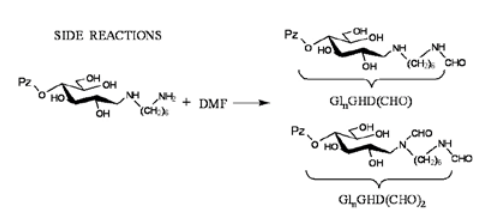
Figure 4. Side reactions in the synthesis of Gl amination